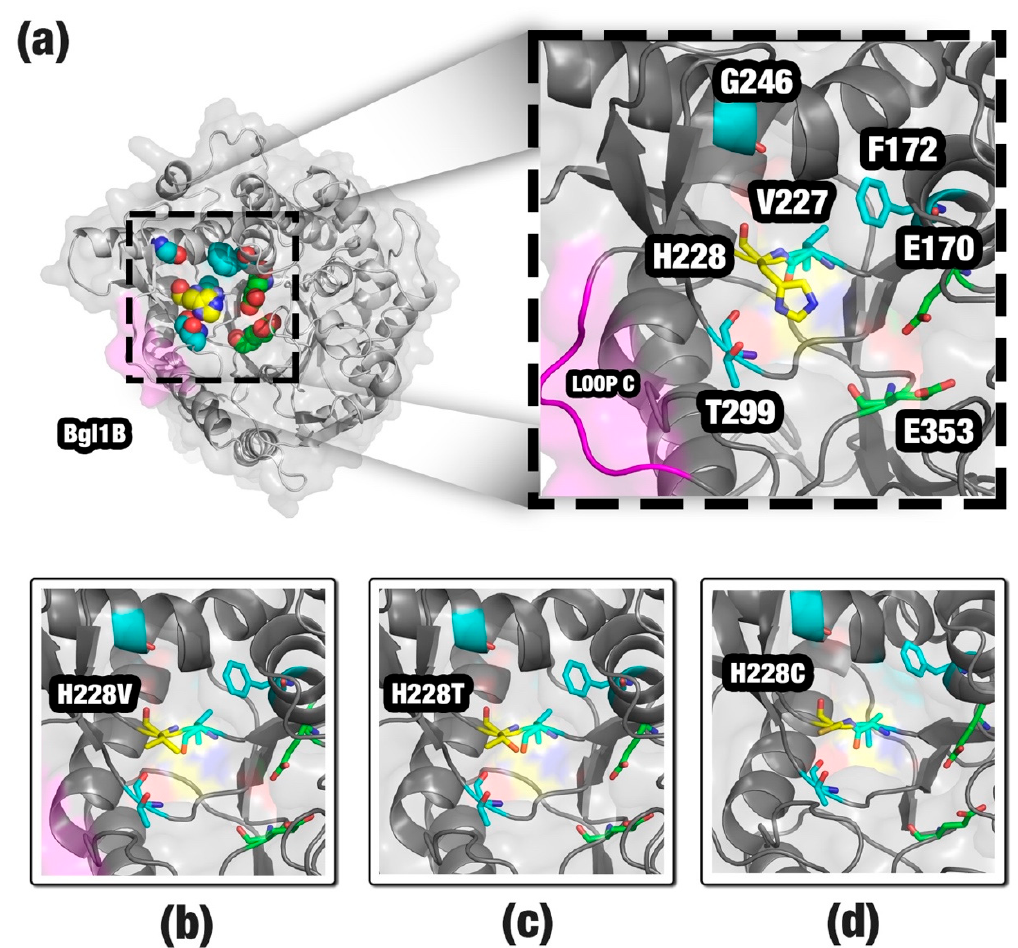
Figure 3. Structure of Bgl1B ( a ), sites pointed by SSV as a target for mutations: H228 residue (yellow); F172, V227, G246, and T229 (cyan). The catalytic residues (E170 and E353) are shown in green. Additionally, loop C is in magenta. For comparison, we highlighted the mutations, H228V ( b ), H228T ( c ) and H228C ( d ), considered by the literature as being responsible for glucose tolerance. Images generated using PyMOL software (http://pymol.org).